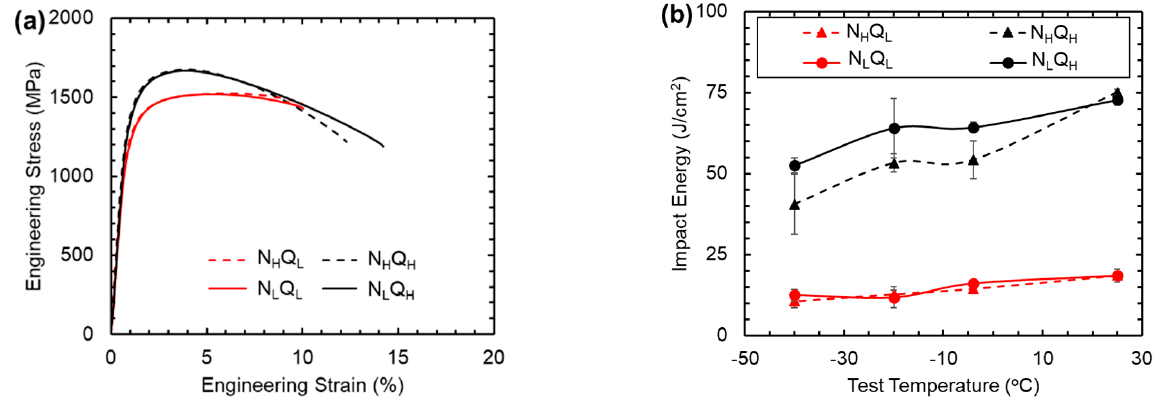
Figure 9. The effect of heat treatment of the alloy on ( a ) quasi-static tensile behavior, ( b ) CVN impact properties as a function of temperature. Table 4. Mechanical properties of the alloy after the various heat treatments.